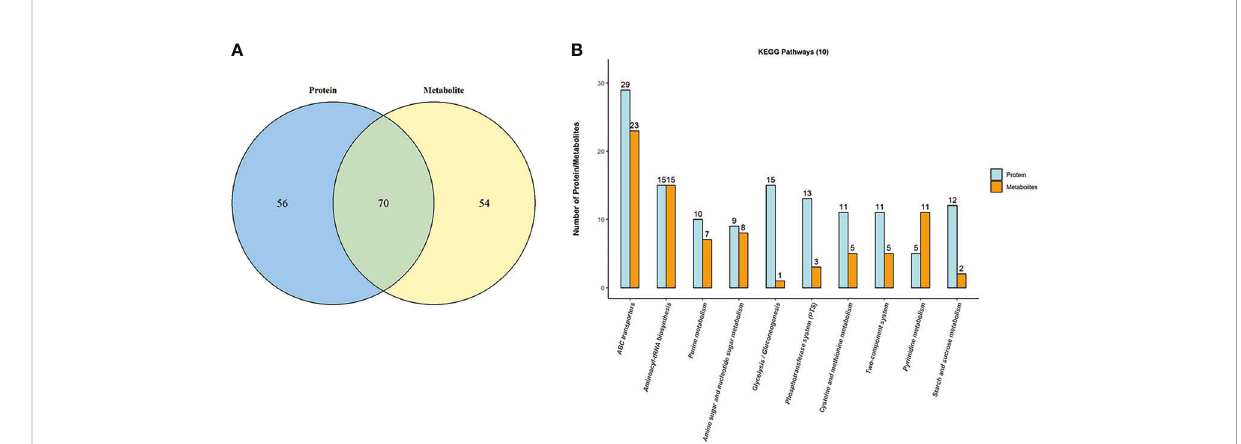
FIGURE 6 Combination analysis of metabolomics and proteomics for EGCG treated SC19. (A) Venn diagram depicting the overlap between metabolites and proteins. (B) The top 10 shared KEGG pathways were shown on the